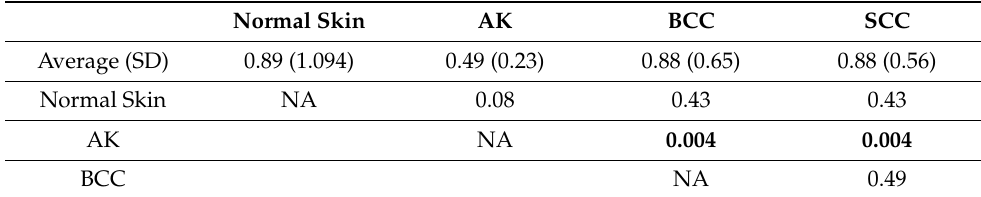
Table 6. Statistical analysis for p -values for VOCT measurement for ratios of weighted displacement peak heights in m for audible sound frequency of 150 Hz/100 Hz *. The sample size is the same as in Table 1 for each group. NA = not